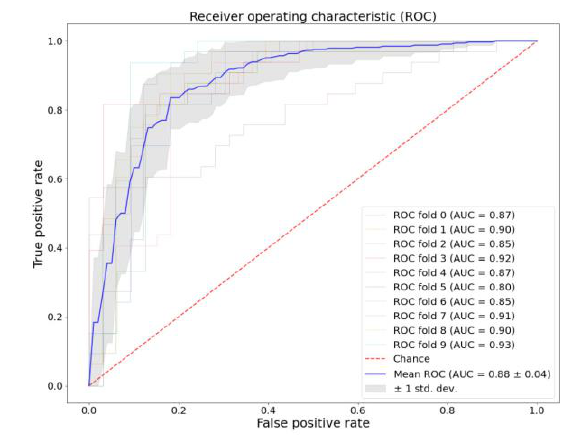
Figure 3 . ROC curve and AUC value of each fold.